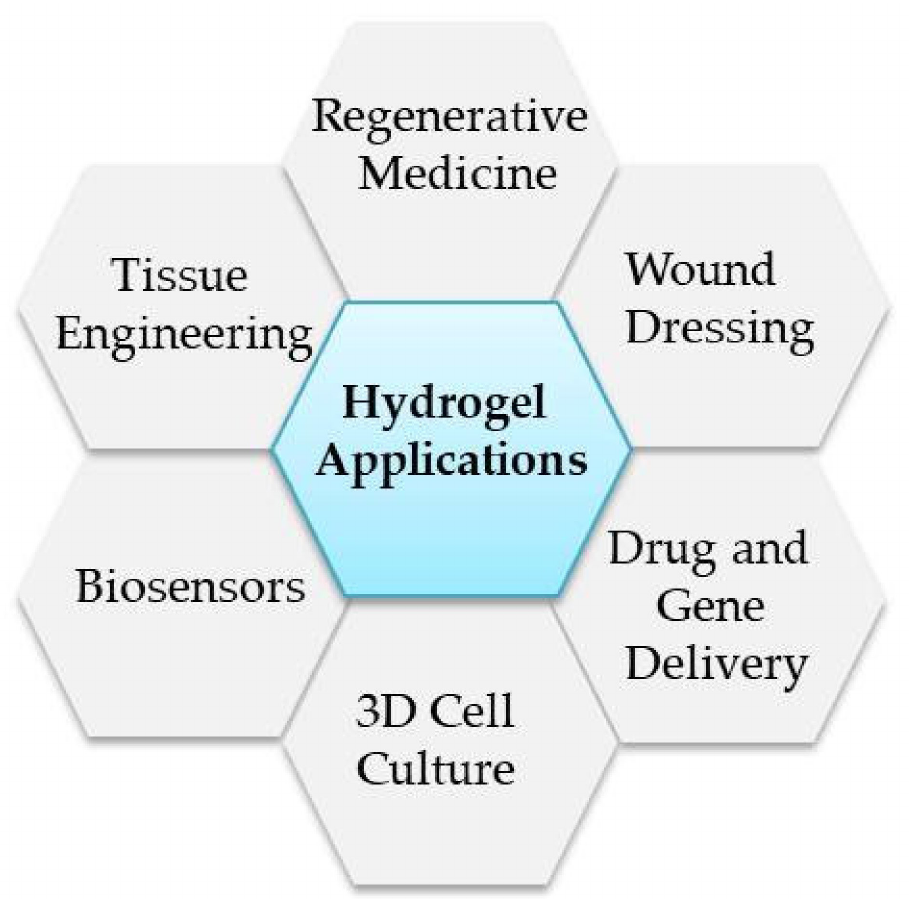
Figure 4. The main hydrogel